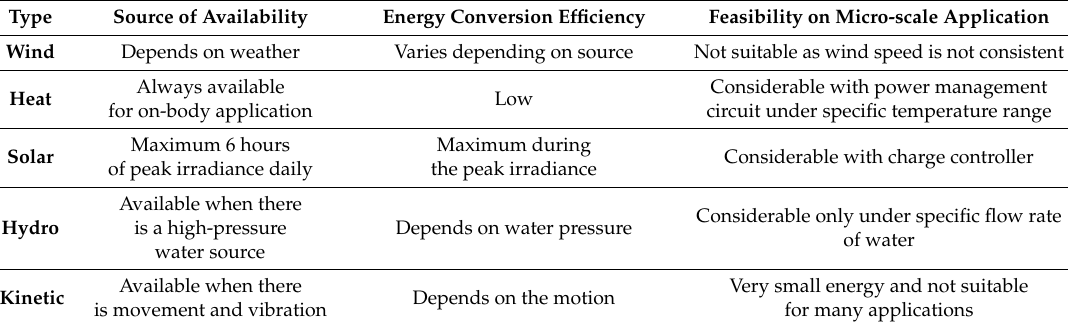
Table 3. Comparison of various energy harvesting